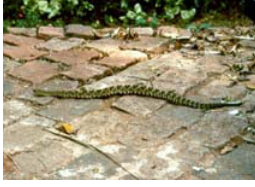
Figure 1: A specimen of Bothrops captured near Araguaína after causing envenomation in a man. This genus caused most of the injuries in this study.